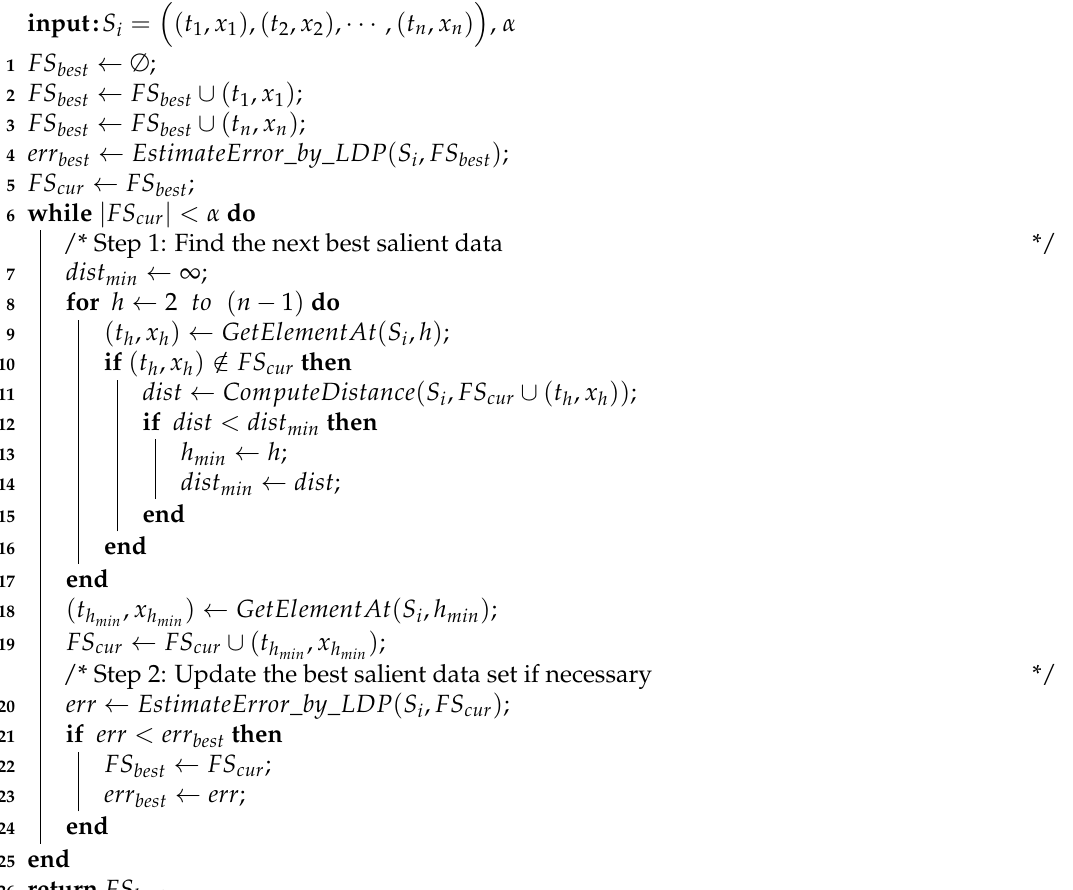
Algorithm 1: Pseudo-code for extracting a set of salient data from a given health data